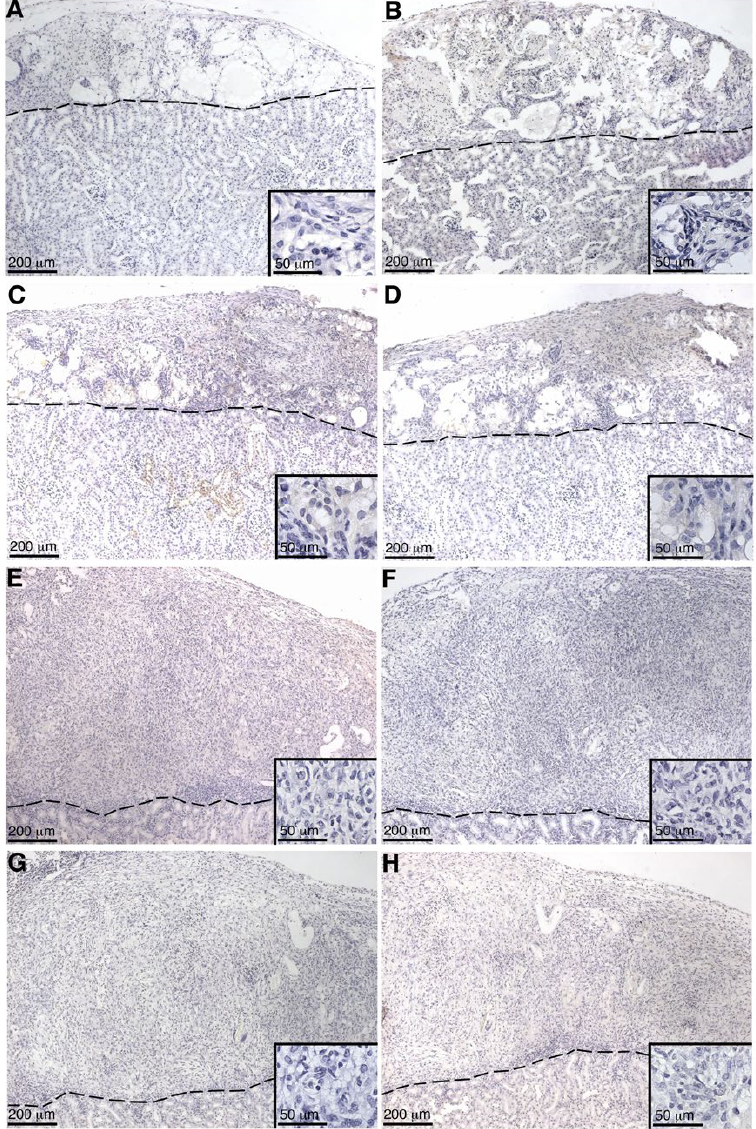
Figure 7. Immunohistochemical analysis of SC grafts for C4 and MAC deposition. Graft-bearing kidneys were collected at days 2 ( A , B ), 5 ( C , D ), 14 ( E , F ), and 20 ( G , H ) days post transplantation, and tissue sections were immunostained for C4 (brown; A , C , E , G ) or MAC (brown; B , D , F , H ). Insets are higher magnifications. A dotted line separates the graft (above the line) from the kidney (below the line). Sections were counterstained with hematoxylin